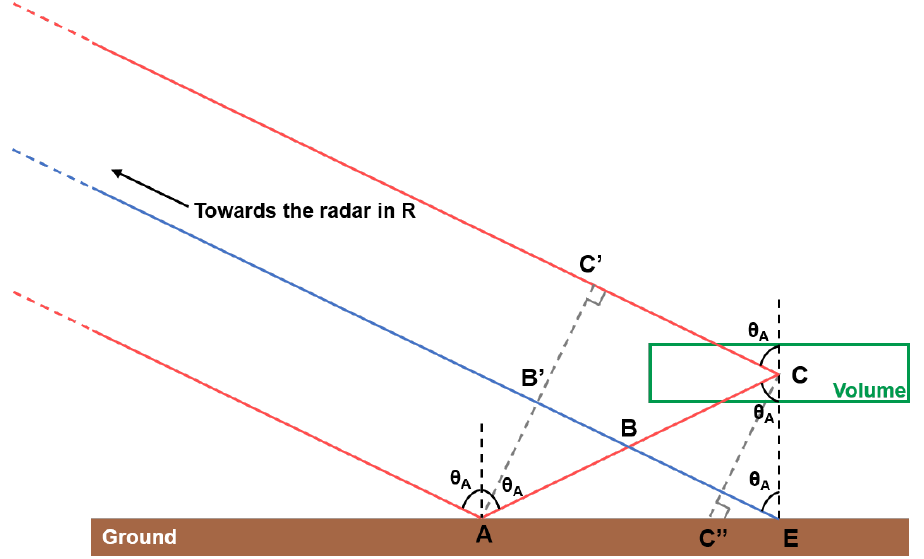
Figure 4. Illustration of DB scattering between a ground and its overlying volume, considering specular paths in far